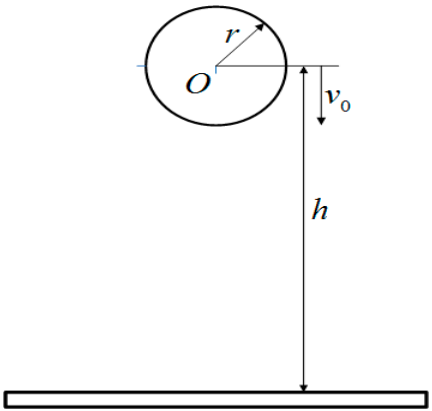
−   −   (12) In the formula: F (cid:2926) and δ (cid:2926) respectively are the load and normal deformation at the onset of a fully plastic stage.